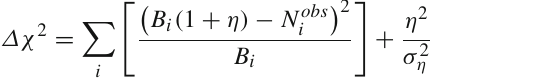
to 2 . 4 × 10 − 3 . The last column shows the prediction for the SM back- ground. The computation is made using the neutrino fluxes as described in the last paragraph of Sect. 4